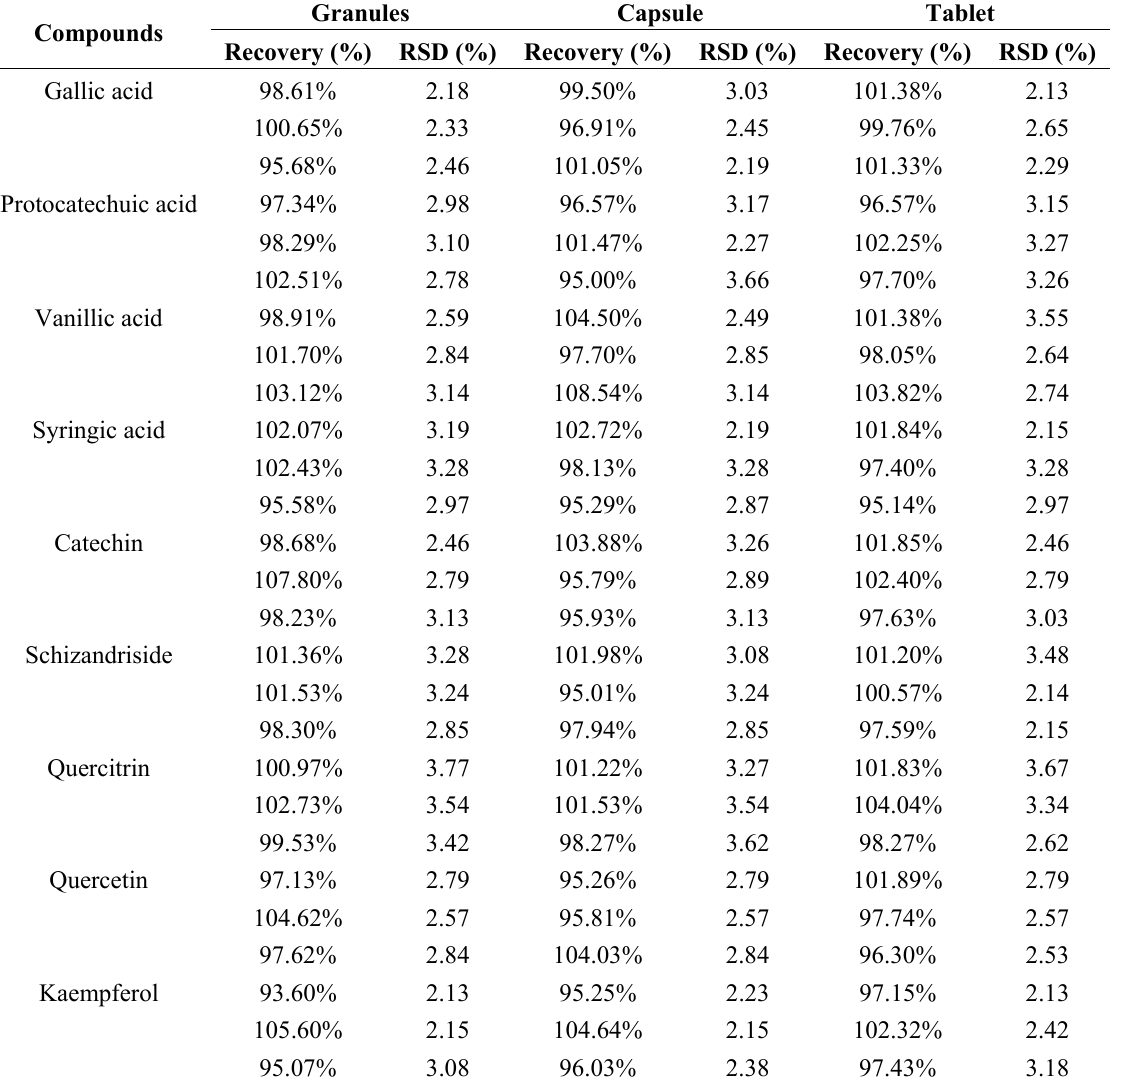
Table 4. Recoveries of the 9 markers (n = 3) in Relinqing ® granules, capsule and tablet. Compounds